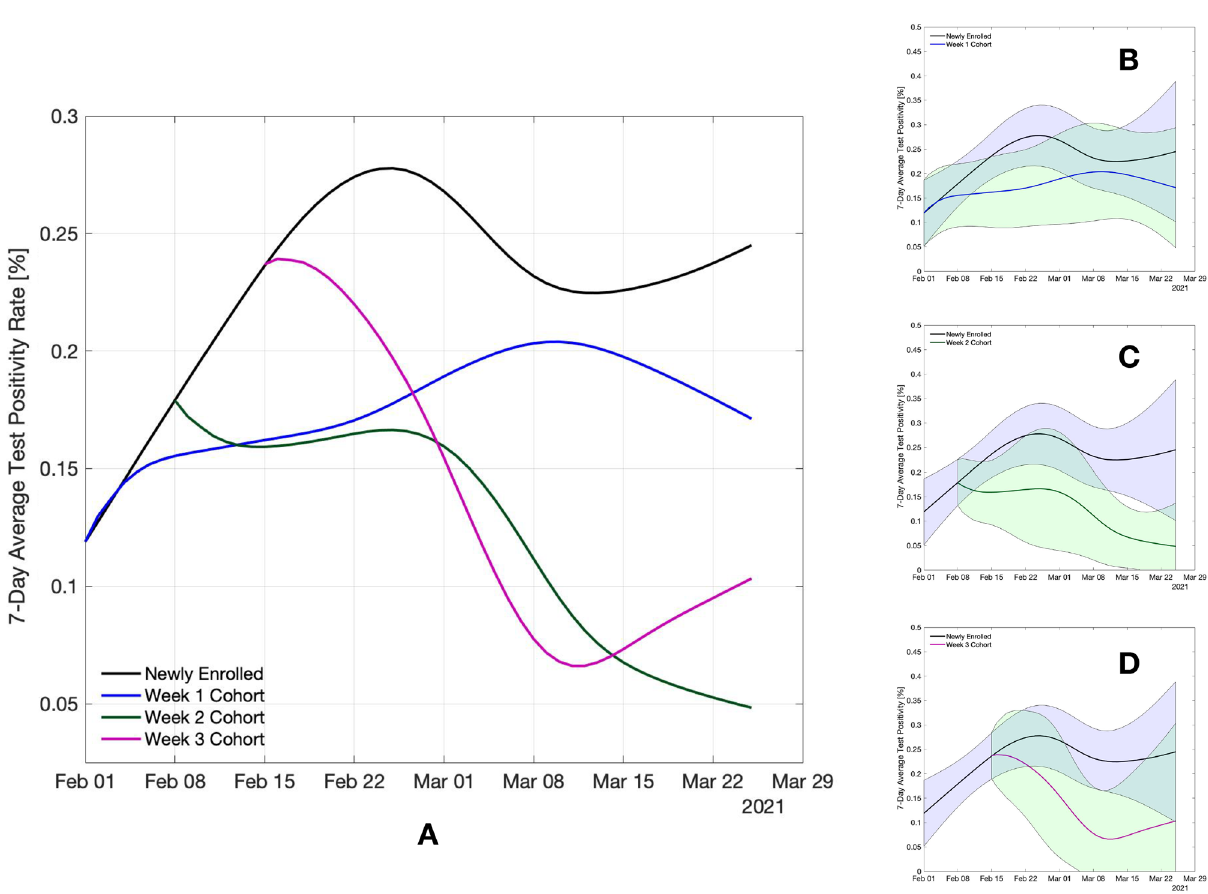
Figure 1. Evolution of TPR (%) for the newly enrolled population as well as other three cohorts considered. ( A ) LOESS fitted 7-day average TPR. ( B – D ) LOESS fitted 7-day average TPR overlaid by 95% CI computed via bootstrapping of the data set (see Fig 4 in Supplementary materials for non-smoothed 7-day